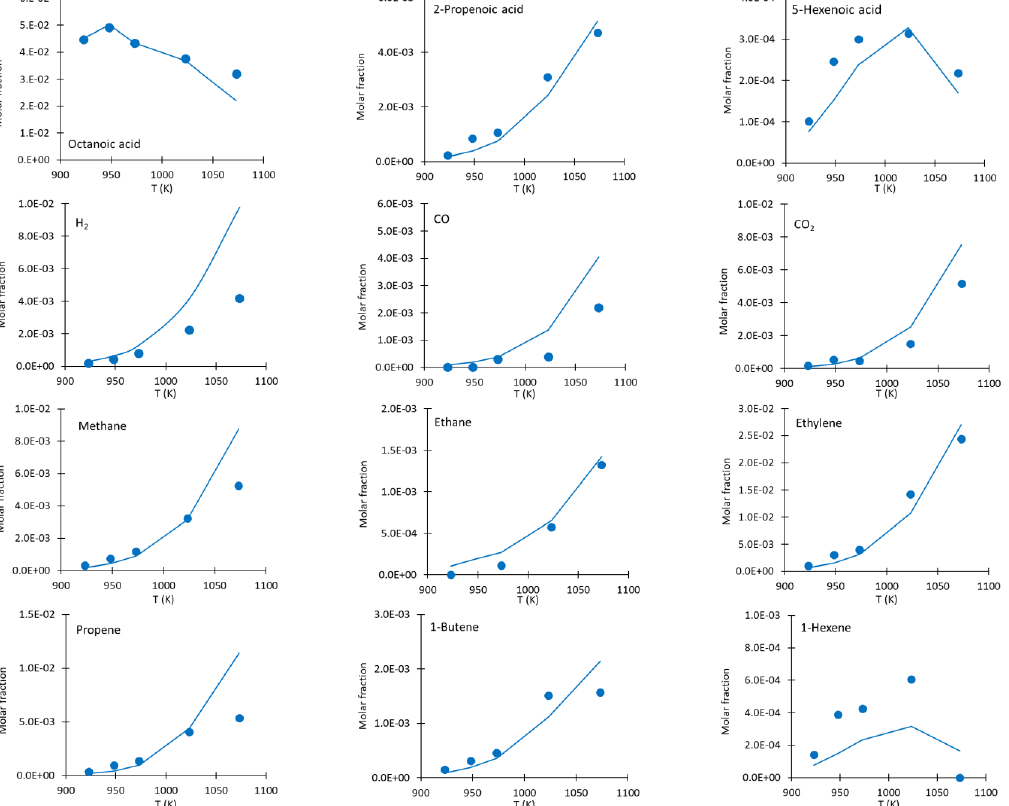
Figure 5. Reactant and key product mole fraction profiles versus oven set point temperature resulting from octanoic acid pyrolysis carried out in the bench-scale setup designed in this work. The mole fraction profiles obtained for the oven set temperature 973.15 K come from this work (Table 5), while the others come from reference [13].